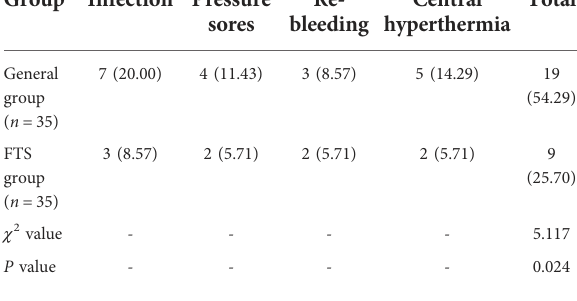
TABLE 2 Comparison of the occurrence of postoperative complications between the two groups of patients ( n , %). Group Infection Pressure Re- sores